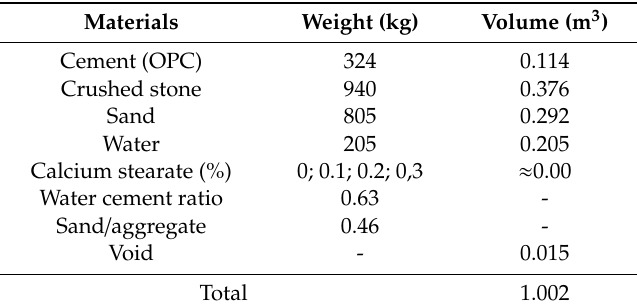
Table 4. Mix proportions of